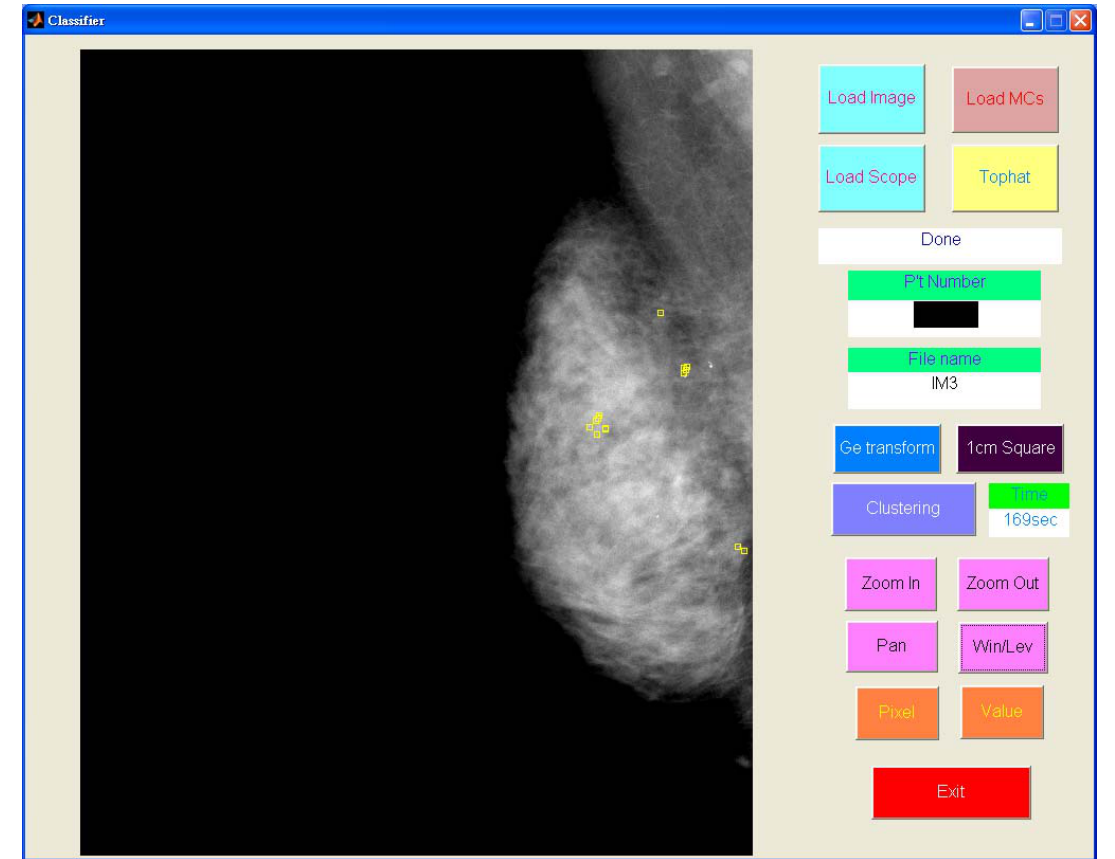
Figure 8. The automated MC detection